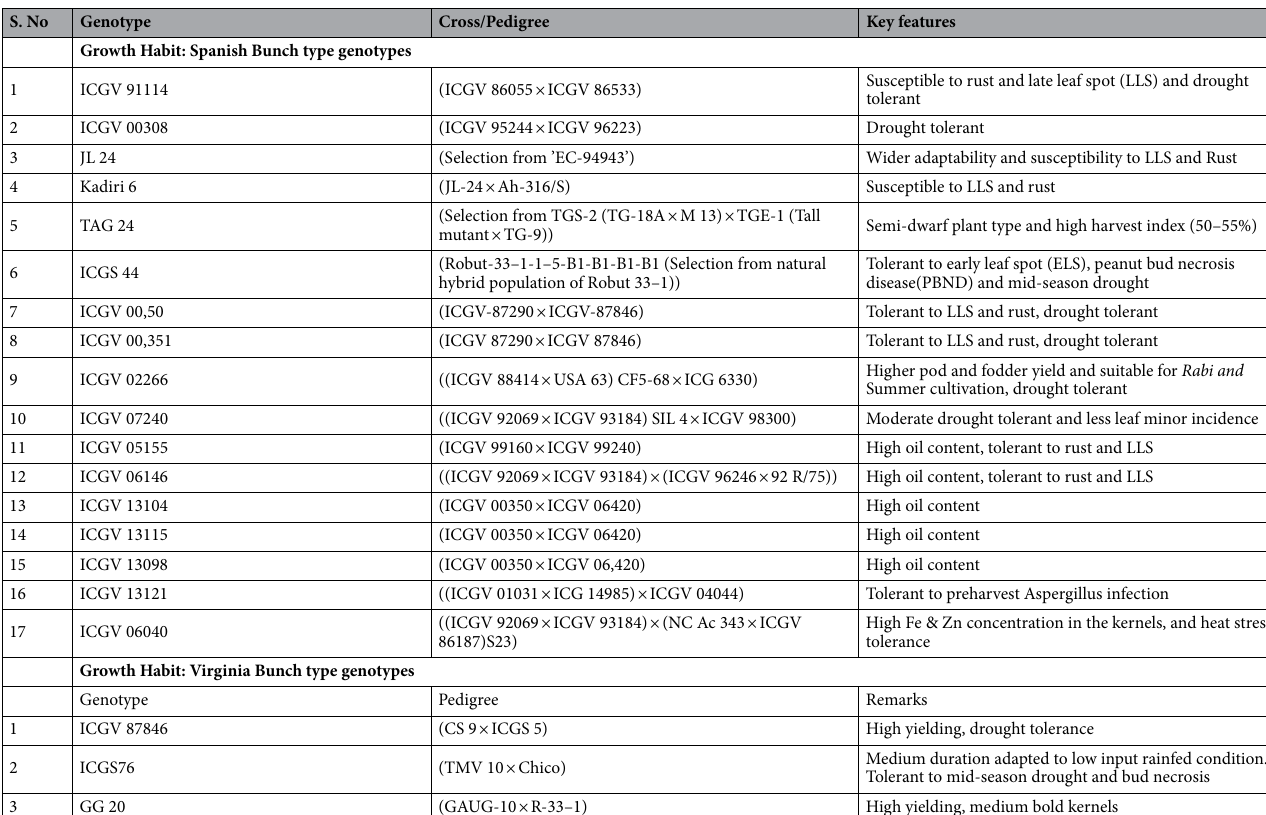
Table 5. Details of groundnut genotypes used in this study. ICGV = ICRISAT Groundnut Variety; ICGS = ICRISAT Groundnut Selection; LLS = Late leaf